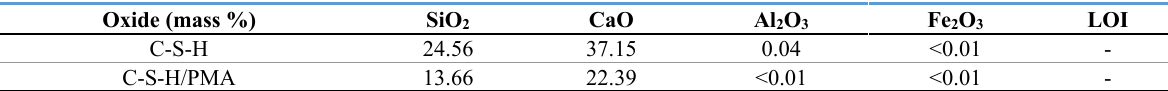
Table 1. Chemical analyses of the C-S-H and C-S-H/PMA (XRF). Oxide (mass %) SiO